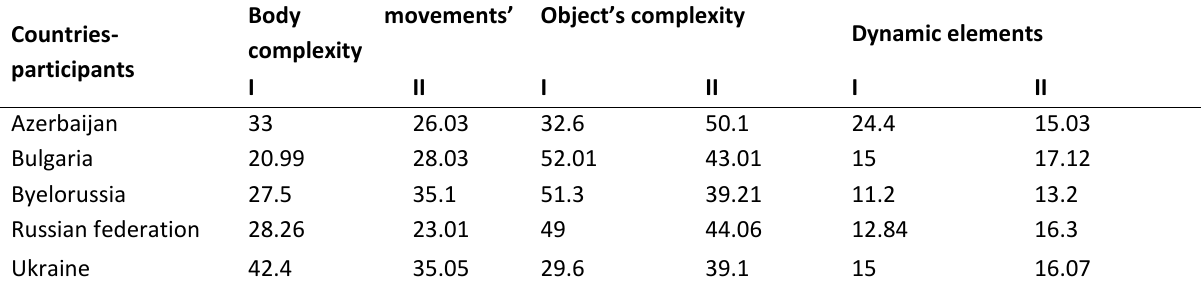
Table 1. Comparative analysis of time indicators of time spent for fulfillment of body movements’ complexity, object’s complexity, dynamic elements in exercise with hoop (n=10)